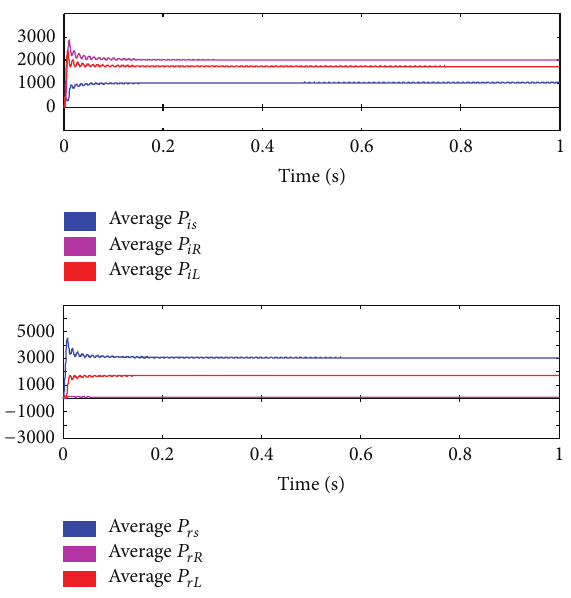
Figure 12: Average power responses for the VRL circuit. the larger amplitude when dealing with incident power ( 𝑃 𝑖𝑠